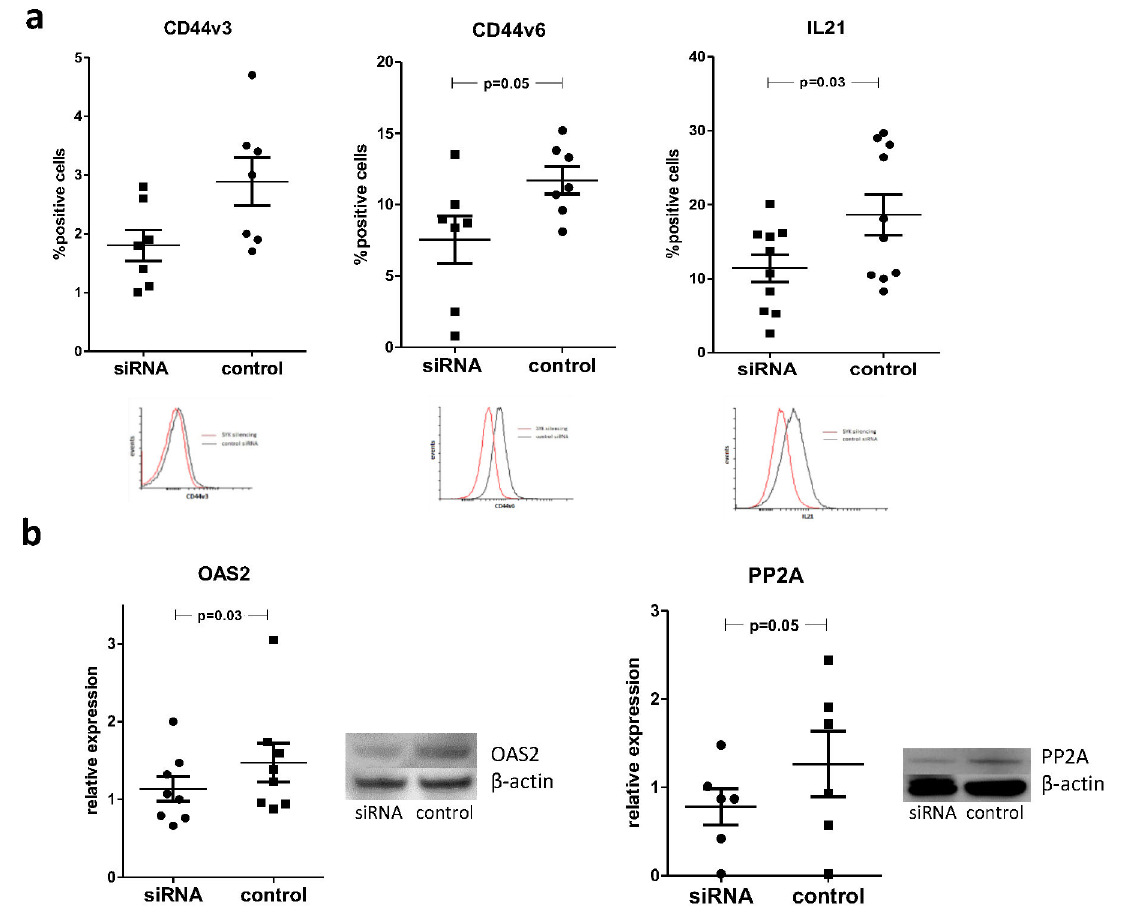
Figure 4. Silencing of SYK results in the suppression of aberrantly expressed molecules in SLE. a) SLE patient T cells were transfected with 15nM of either control or SYK-specific siRNA. Seventy-two hours following transfection cells were harvested and stained with antibodies against IL-21, CD44v3 and CD44v6. Silencing of SYK resulted in the suppression of expression of all the above molecules, particularly IL-21 and CD44v6. Bars show the mean ±SEM of control (control) vs. SYK-siRNA (siRNA) transfected T cells in ≥7 experiments and a representative experiment is shown. b) Protein expression levels of OAS2 and PP2a measured in western blot were found to decrease following silencing of SYK. Mean ±SEM of densitometry analyses of SYK-specific (siRNA) vs. control (control) siRNA transfected cells in ≥6 experiments are plotted. A representative experiment and cumulative data are